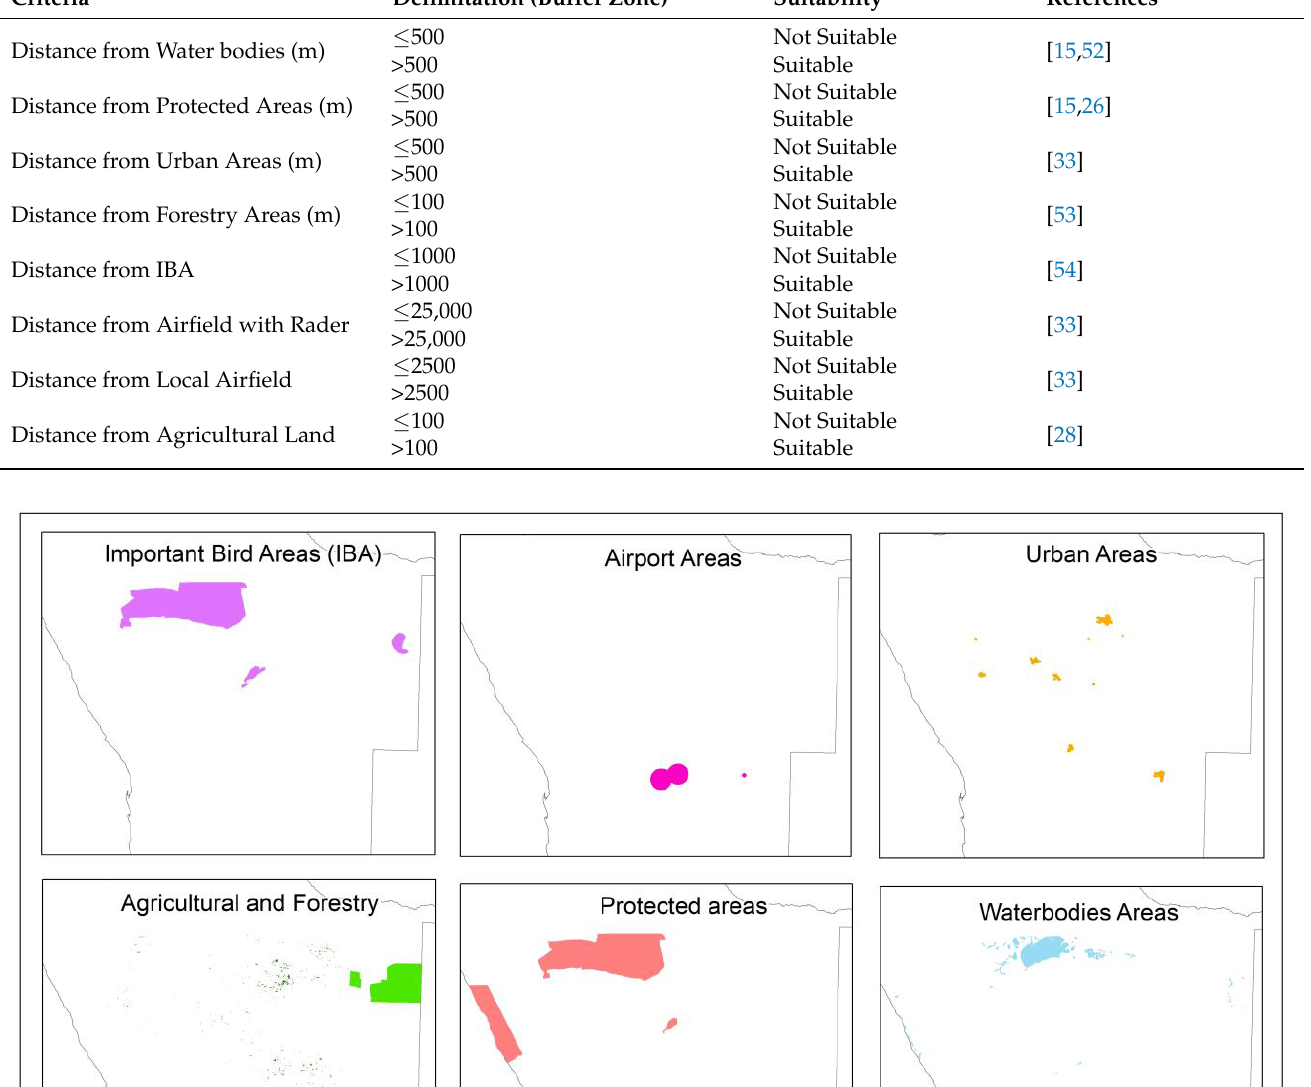
Table 4. Constraints involved in installing solar PV and wind power plants.